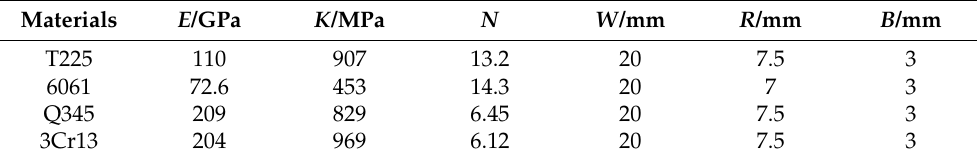
Table 3. Mechanical parameters and corresponding geometric dimensions of the materials.